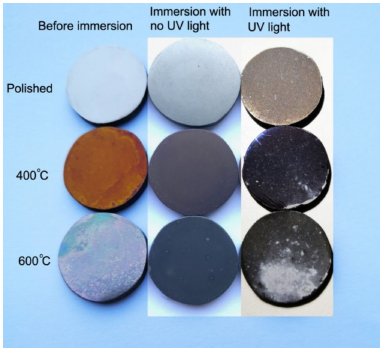
Figure 3. Comparison of CP-Ti pieces’ appearances before and after immersion. The pieces’ appearances with no UV light irradiation is also shown.